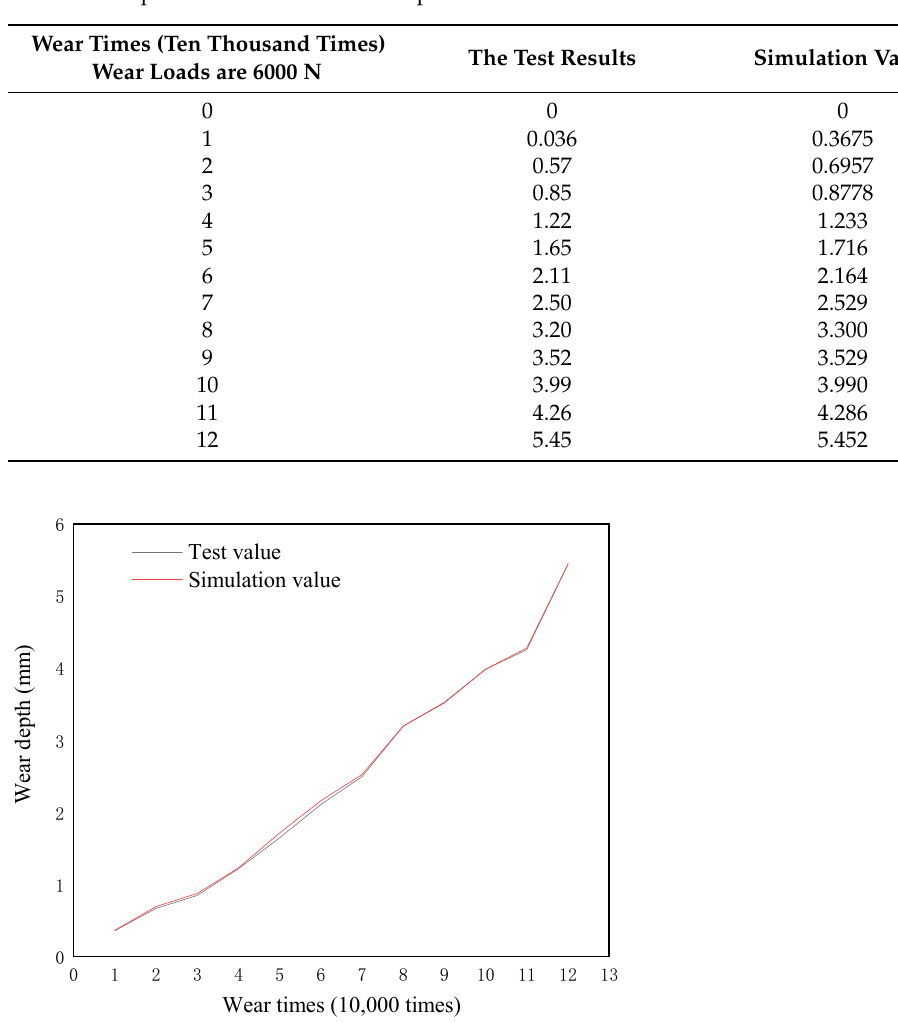
Table 6. Comparison of simulated and experimental values with the number of wear at 6000 N.